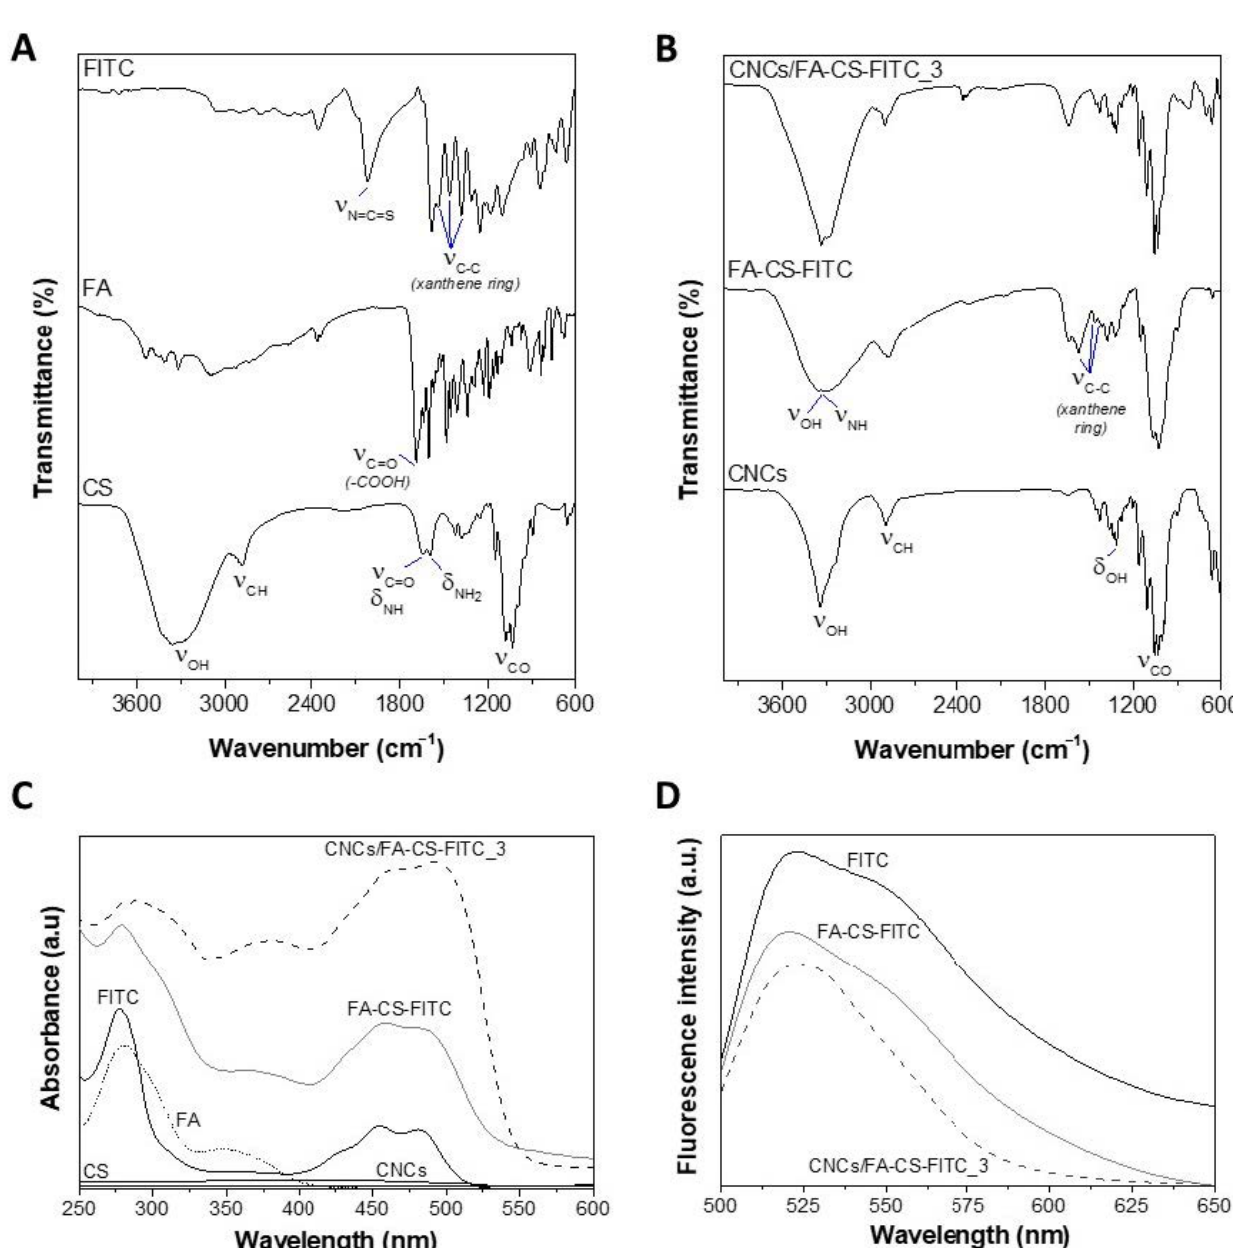
Figure 2. ( A ) FTIR-ATR spectra (vibrational modes: ν = stretching, δ = bending) of the pure CS, FA and FITC, ( B ) FTIR-ATR spectra of the pristine CNCs, FA-CS-FITC derivative and CNCs/FA-CS-FITC_3 nanosystem, ( C ) UV-vis spectra of CNCs, CS, FA, FITC, FA-CS-FITC derivative and CNCs/FA-CS-FITC_3 nanosystem, and ( D ) fluorescence emission spectra of the FITC, FA-CS-FITC derivative and CNCs/FA-CS-FITC_3 nanosystem. The UV-vis spectrum of the CNCs/FA-CS-FITC_3 nanosystem (Figure 2C)